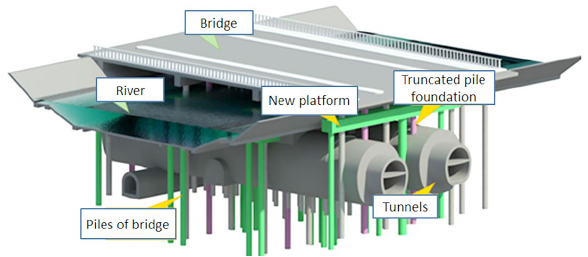
Figure 12. Subway Line 19 crossing rivers and